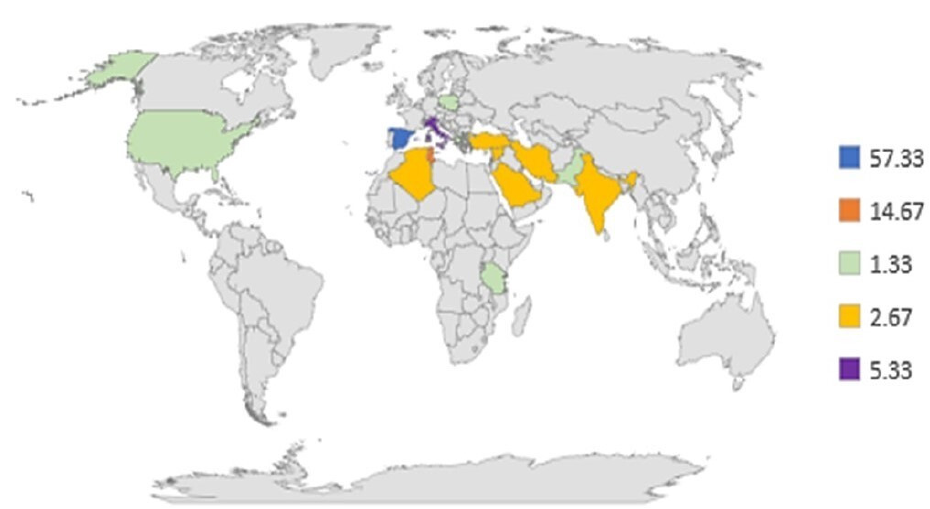
Figure 2. Distribution of articles by country. Spain, 57.33%; Tunisia, 14.67%; Italy, 5.33%; India, Iran, Arabia, Algeria, Turkey, and Syria, 2.67%; Greece, Pakistan, Tanzania, USA, Poland, 1.33%.